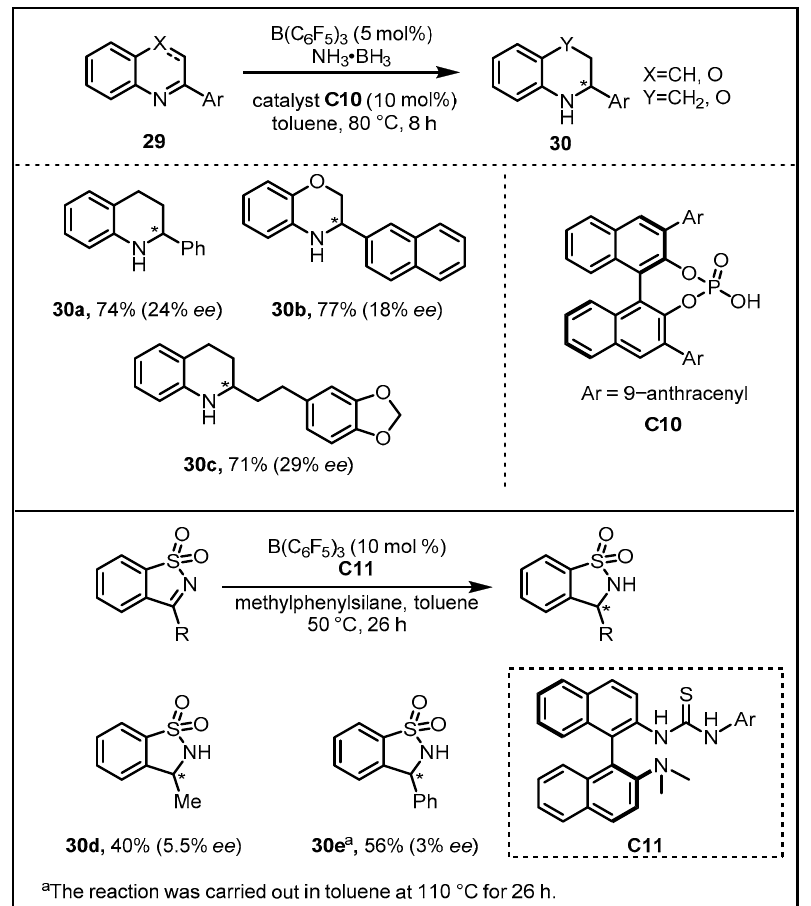
Figure 12. Asymmetric transfer hydrogenations of quinolines and indole derivatives.